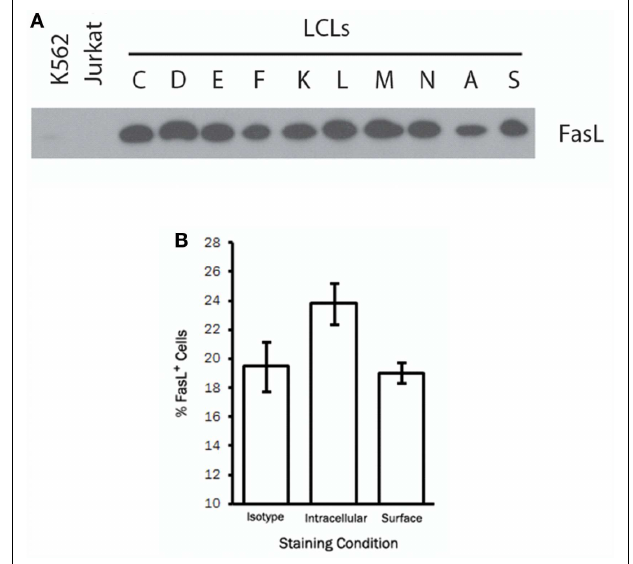
FIGURE 1 |A high frequency of LCL constitutively produce intracellular FasL protein. (A) Equivalent numbers of LCL and control cell lines were lysed and probed for expression of FasL protein by immunoblot. (B) LCL were fixed and stained for surface FasL, or permeabilized with saponin buffer for intracellular FasL staining by flow cytometry. An isotype control antibody was used to control for non-specific binding on the cell surface and following cell permeabilization. Results are representative of at least three LCL